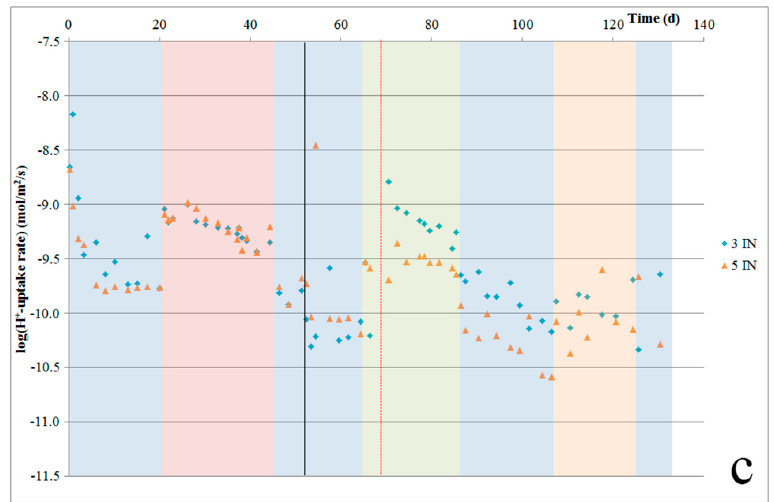
Figure 8. H + -uptake rates calculated per sample, based on measured cation release rates, plotted against time, for ( a ) Åheim dunite, ( b ) nepheline syenite, and ( c ) ilmenite norite.